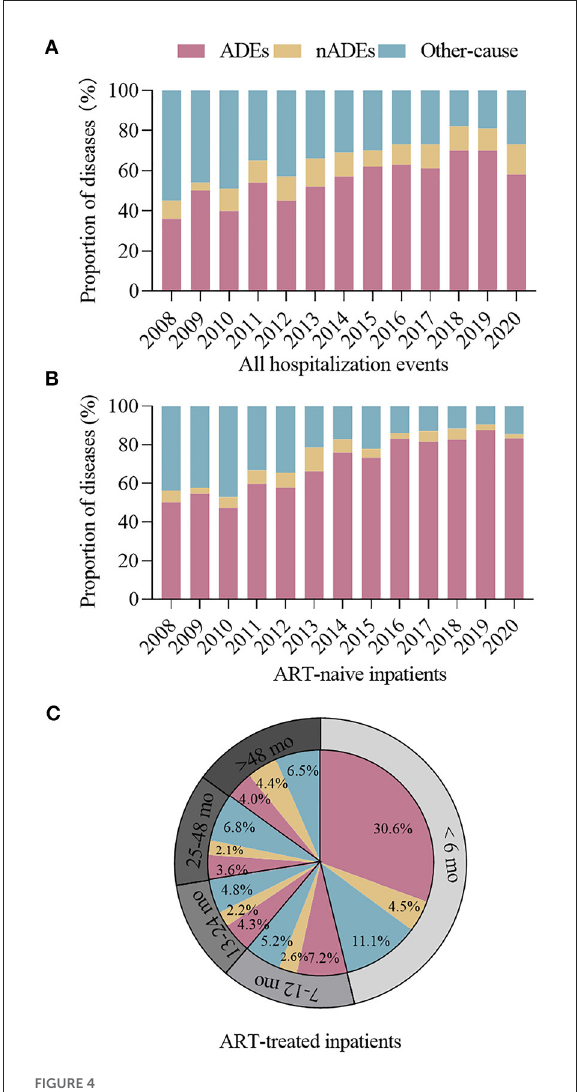
FIGURE4 Proportion of hospitalizations for ADEs, nADEs, and other causes among (A) all hospitalized cases and (B) ART-naive cases, 2008–2020. (C) Proportion of hospitalizations for ADEs, nADEs, and other causes among cases with different ART durations. ADE, AIDS-defining events; nADEs, non-AIDS-defining events; ART, antiretroviral therapy.